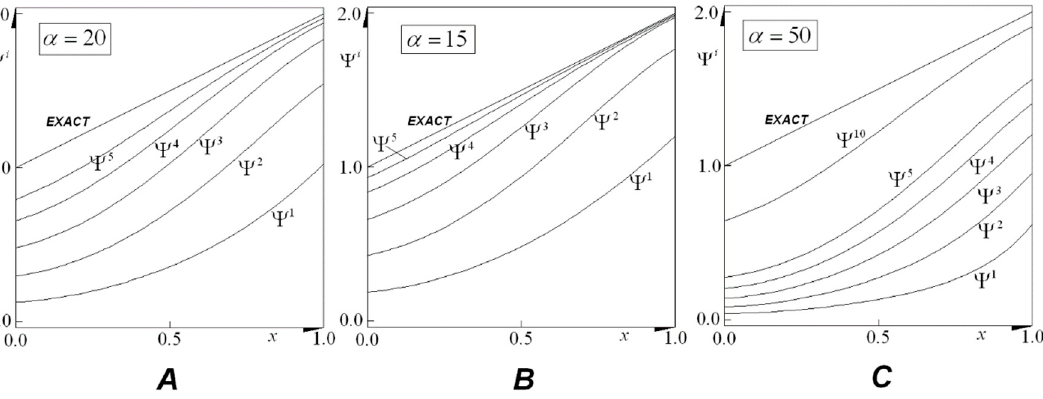
(cid:104) (cid:105) Ψ 0 , Ψ 1 , Ψ 2 , Ψ 3 , . . . Figure 1. Some elements of the sequence obtained with three different values Ψ Ψ Ψ Ψ Figure 1. Some elements of the sequence 0 1 2 3 , , , ,...     obtained with three different val- α α α= → = → = → = α ues of the constant ( 20 , 15 , 50 A B C ). In all cases, 50 N .